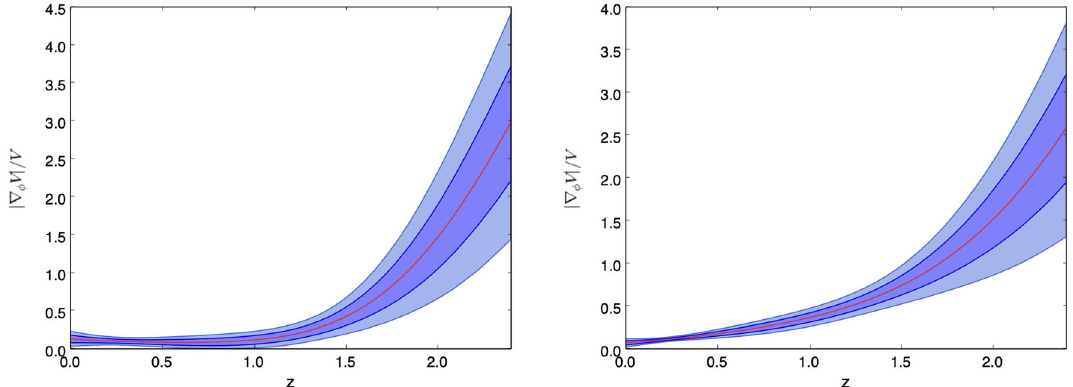
Fig. 10 The GP reconstruction of | V (cid:3) | / V , Eq. (30), for the 30 H ( z ) samples deduced from the differential age method with 10 additional samples obtained from the radial BAO method (Table 1) is presented on the left hand side plot, when H 0 = 73 . 52 ± 1 . 62 km s − 1 Mpc − 1 has been merged to the expansion rate data used in the GP. The right hand side plot represents the GP reconstruction of | V (cid:3) | / V , Eq. (30), when